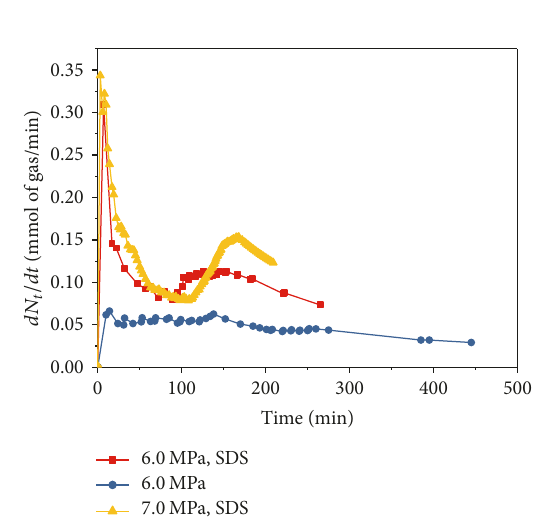
Figure 6: Rate of hydrate formation in different